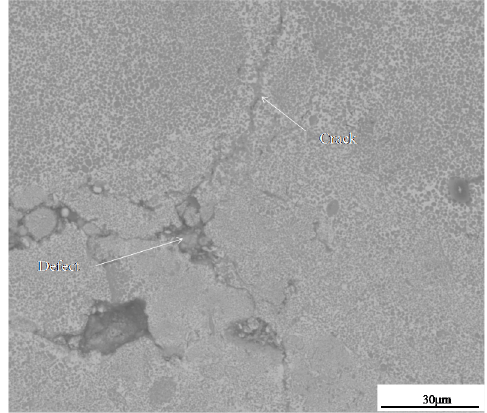
Figure 14. Crack propagation in the coating.